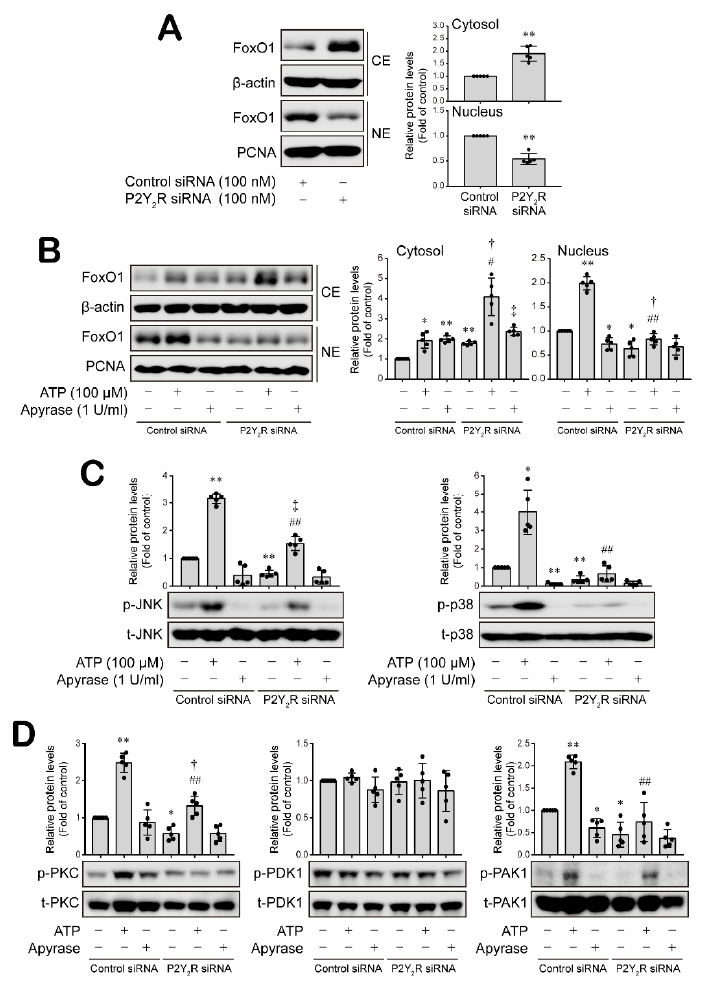
Figure 7. ATP-induced activation of P2Y 2 R regulated ESM-1 expression through the PAK1-JNK/p38 MAPK-FoxO1 signaling cascades in RT-R-MDA-MD-231 cells. ( A ) Nuclear/cytosolic protein was extracted from control or P2Y 2 R short interfering RNA (siRNA)-transfected RT-R-MDA-MB-231 cells, and FoxO1 protein levels in the cytosol and nucleus were analyzed by Western blotting. β -Actin and PCNA were used as loading controls. The values are presented as the mean ± SD of five independent experiments. ** p < 0.01 compared to the control siRNA-transfected cells. ( B ) After control or P2Y 2 R, siRNA-transfected RT-R-MDA-MB-231 cells were treated with ATP or apyrase for 8 h, and FoxO1 protein levels in the cytosol and nucleus were analyzed by Western blotting. ( C ) Control or P2Y 2 R siRNA-transfected RT-R-MDA-MB-231 cells were treated with ATP or apyrase for 5 min to detect JNK and for 60 min to detect p38, respectively. Phospho- and total JNK or p38 protein expression levels were analyzed from total protein fraction of cells by Western blotting. ( D ) Control or P2Y 2 R siRNA-transfected RT-R-MDA-MB-231 cells treated with ATP or apyrase were then treated for 5 min, and phospho- and total PKC, PDK1, or PAK1 protein levels were detected by Western blotting. The values are presented as the mean ± SD of five independent experiments. * p < 0.05, ** p < 0.01 compared to the control group in the control siRNA-transfected cells; # p < 0.05, ## p < 0.01 compared to the ATP-treated group in the control siRNA-transfected cells; † p < 0.05, ‡ p < 0.01 compared the control group in the P2Y 2 R siRNA-transfected cells. CE, cytosolic extract; NE, nuclear